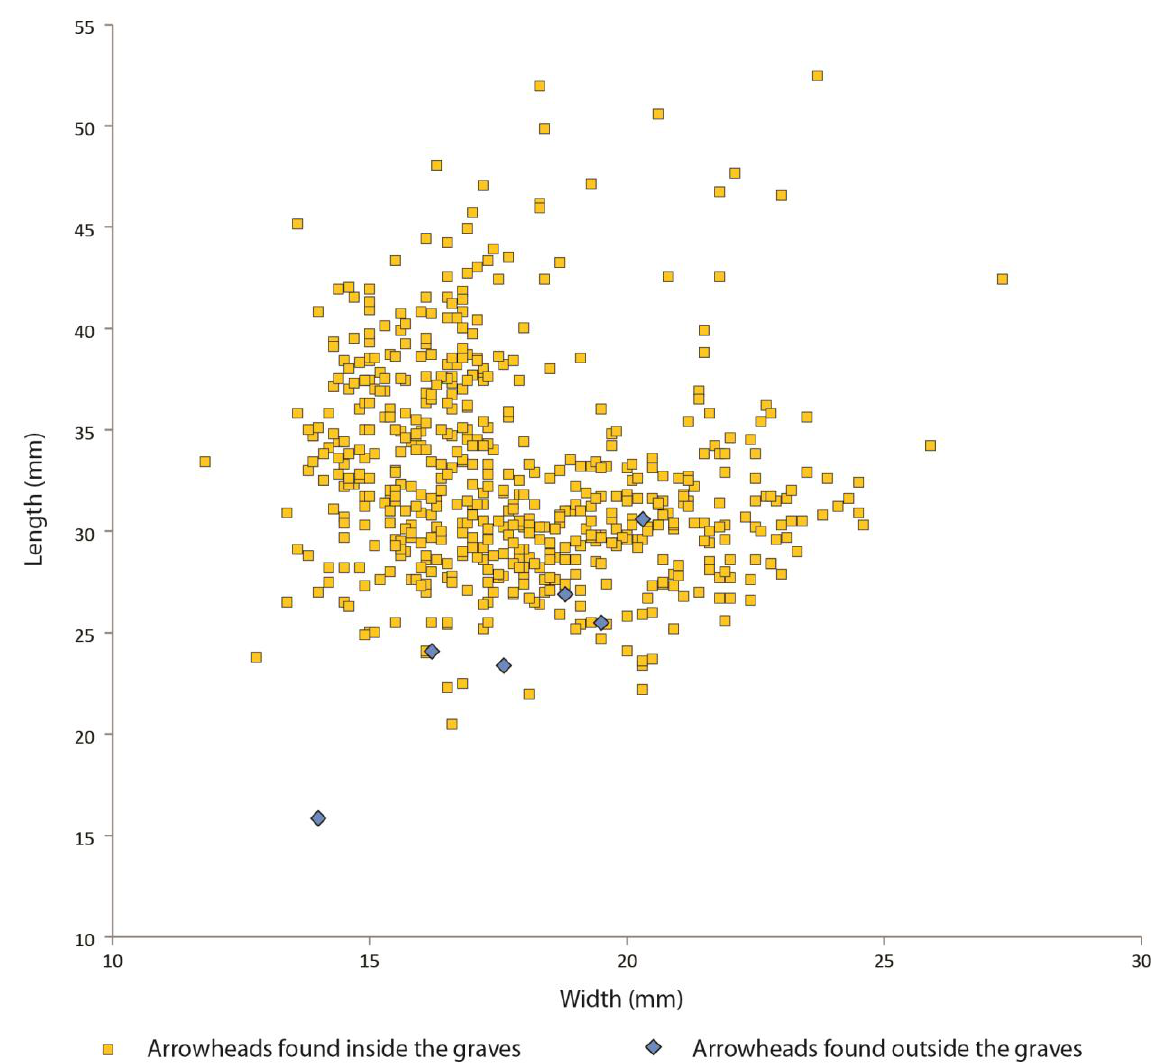
Figure 2. Comparison between arrowheads found inside and outside the